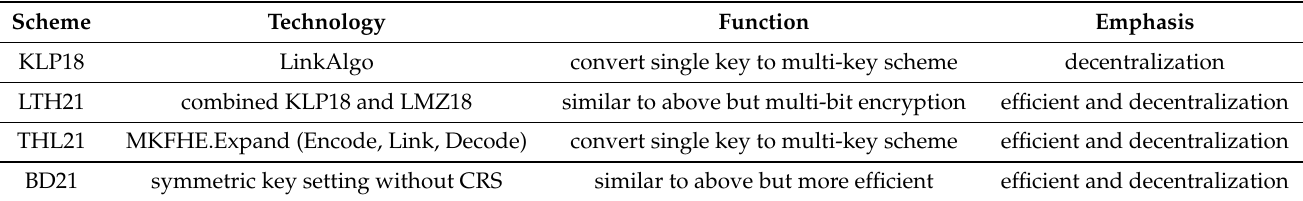
Table 2. Summary of Section